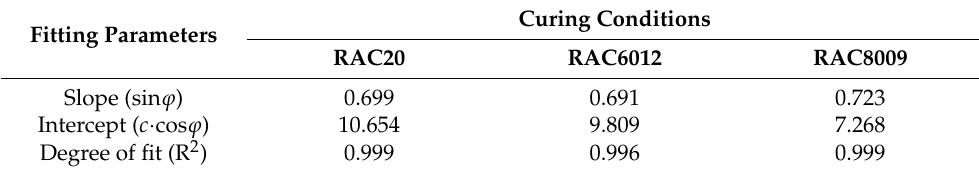
Table 4. Fitting parameters determined by the Mohr–Coulomb criterion.